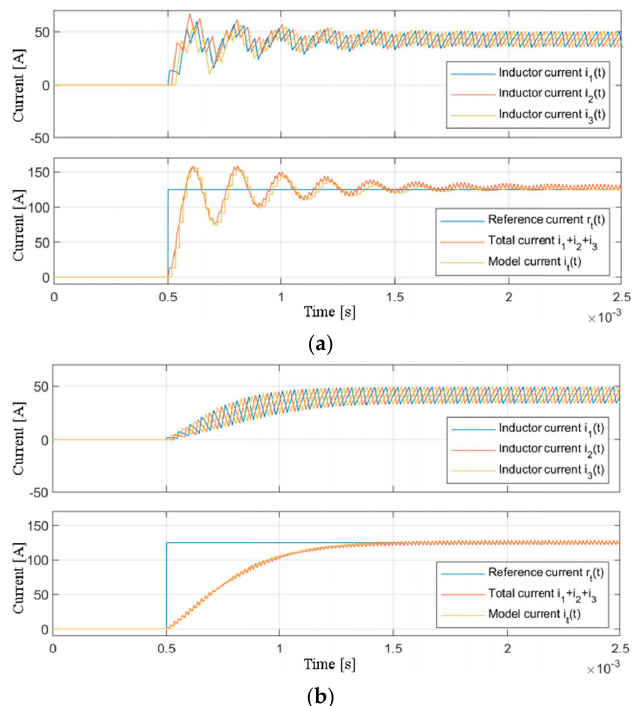
Figure 11. Current step responses with the method proposed in [13] ( a ) and with the method proposed in this paper ( b ).